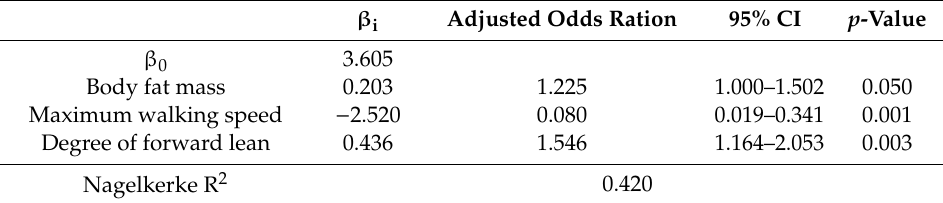
Table 4. Logistic regression model for the prediction of locomotive syndrome incidence †